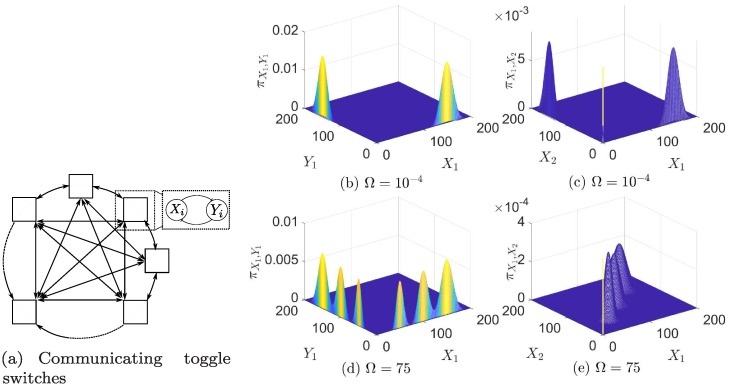
SPK lead to the emergence of a multi- modal toggle switch (a) A diagram of population of toggle switches. Arrows between blocks represent reversible diffusion reactions. Each block contains a toggle switch. The remaining subfigures show stationary PMFs for a population of three identical cooperative toggle switches. Due to the symmetries we plot joint PMFs of X1, Y1 and X1, X2 only. Subplots (b), (c) depict the uncoupled toggle switches. Note that X1 and X2 are not synchronized. Subplots (d), (e) depict a high diffusion case. The toggle switches synchronize into a multi-modal toggle switch. More details are given S1 Text §6.4.